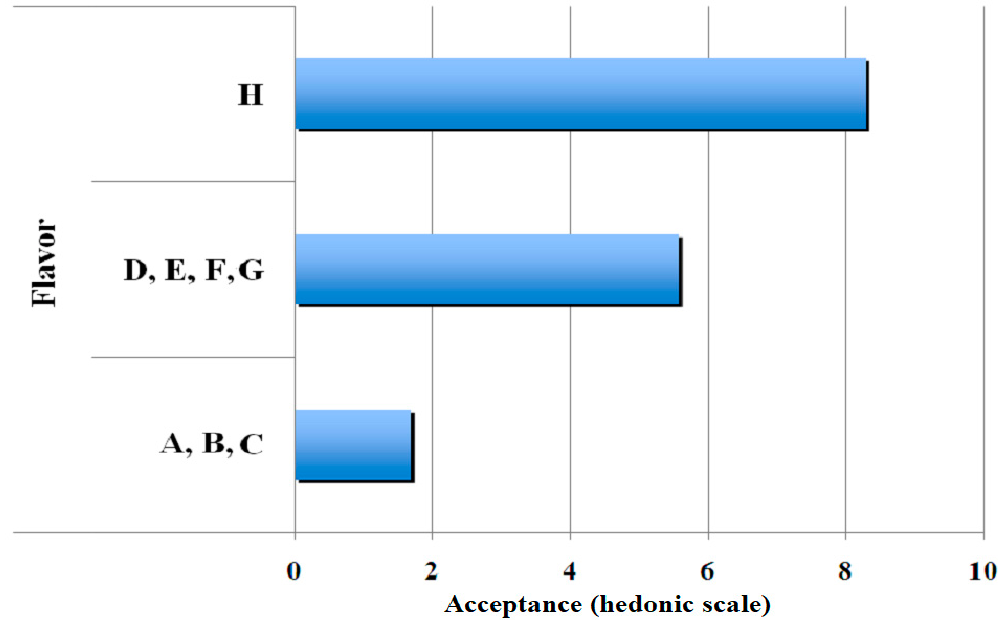
Figure 3. Results of clustering of gelatin-base gel samples for the attribute, flavour.